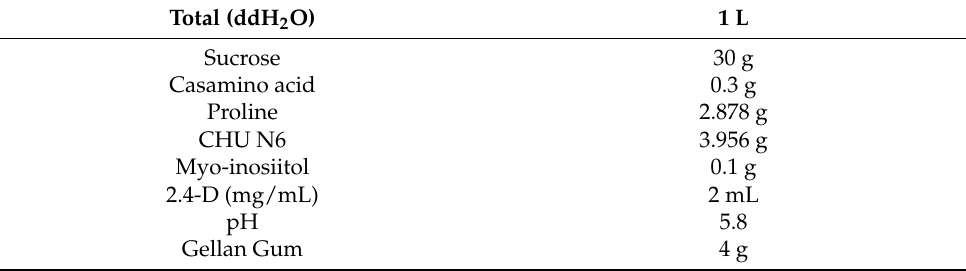
Table 1. The composition of the medium inducing rice stem